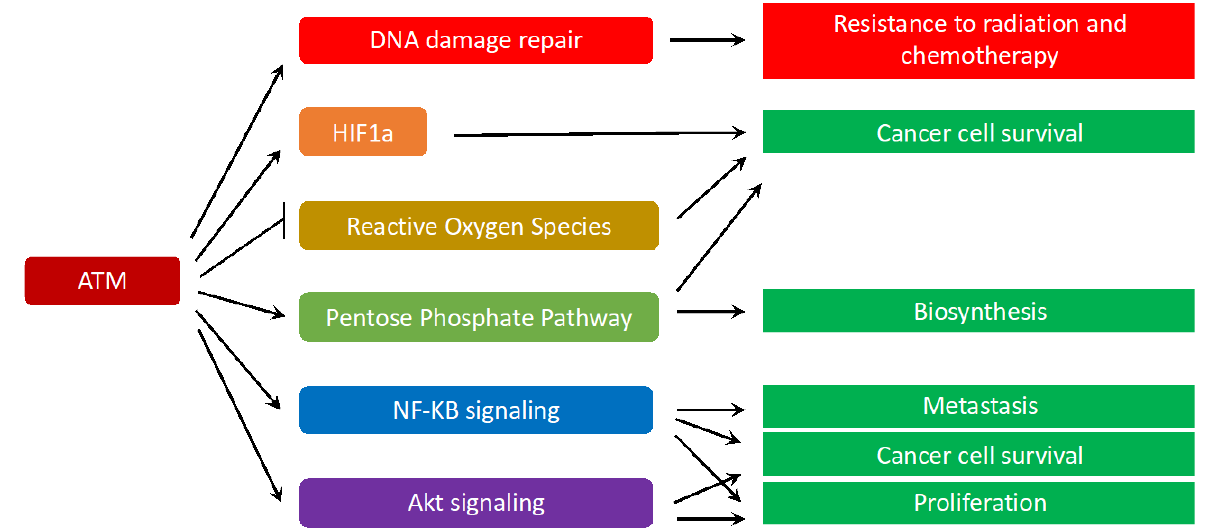
Figure 4. The diverse roles of ATM in cancer cells. In some cancer cells that have developed mechanisms to evade apoptosis and cell cycle arrest, increase in ATM signaling may confers significant advantages for cancer cell survival, biosynthesis, proliferation, metastasis, as well as resistance to radiation and chemotherapy.